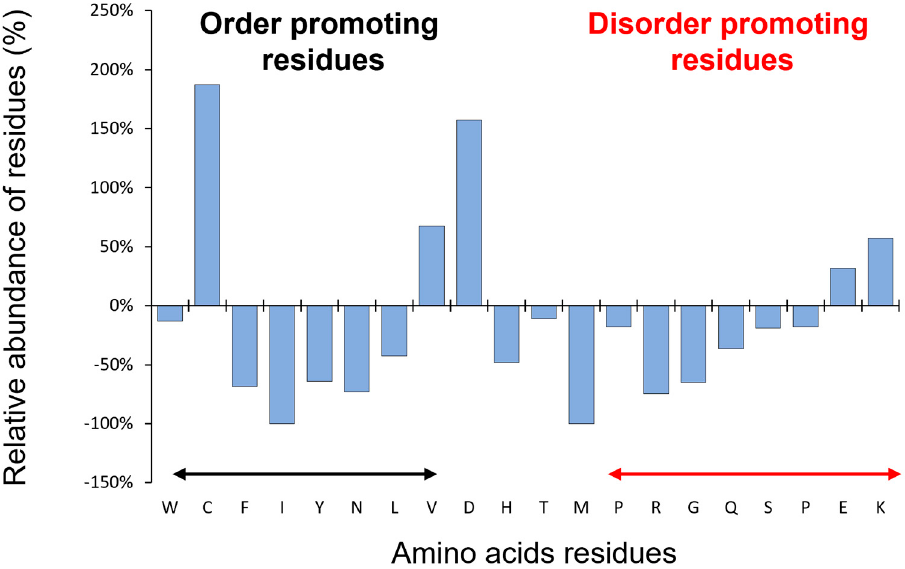
Figure 3. CP12 presents a bias in amino acid composition. Comparison of amino acid composition between globular proteins and C. reinhardtii CP12 using composition profiler (http://www.cprofiler.org (accessed on 25 July 2022)) [40]. The globular proteins dataset is from protein data bank (PDB) Select 25.